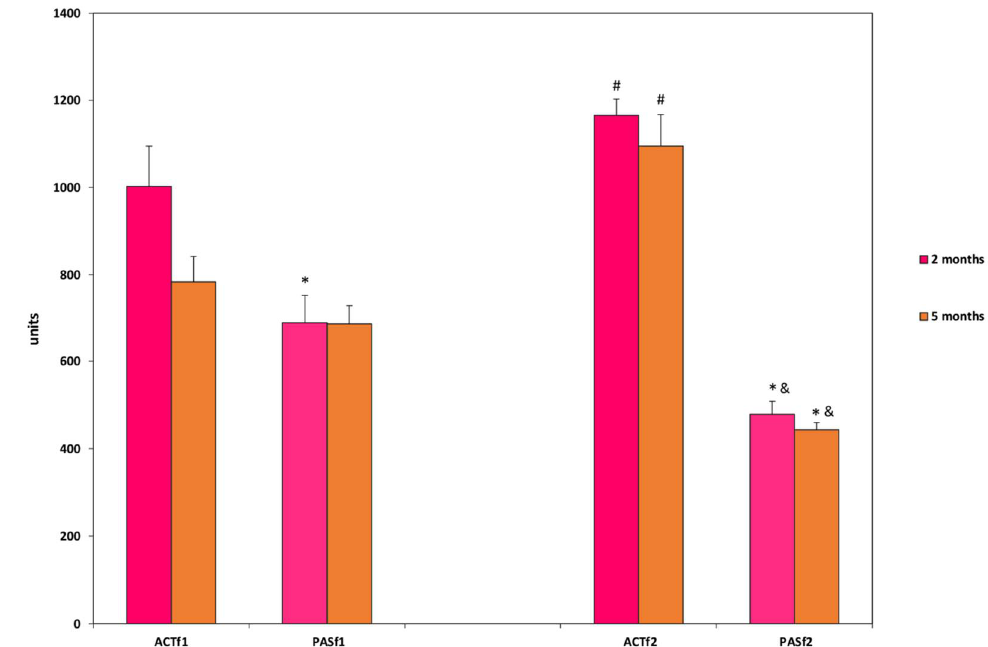
Figure 2. Total horizontal motor activity of female rats for 60 min. * p < 0.05 between ACTf and PASf; # p < 0.05 between ACT1 and ACT2; & p < 0.05 between PAS1 and PAS2.